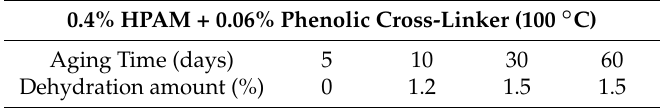
Table 3. Dehydration amount (%) in isograms of gels under reservoir